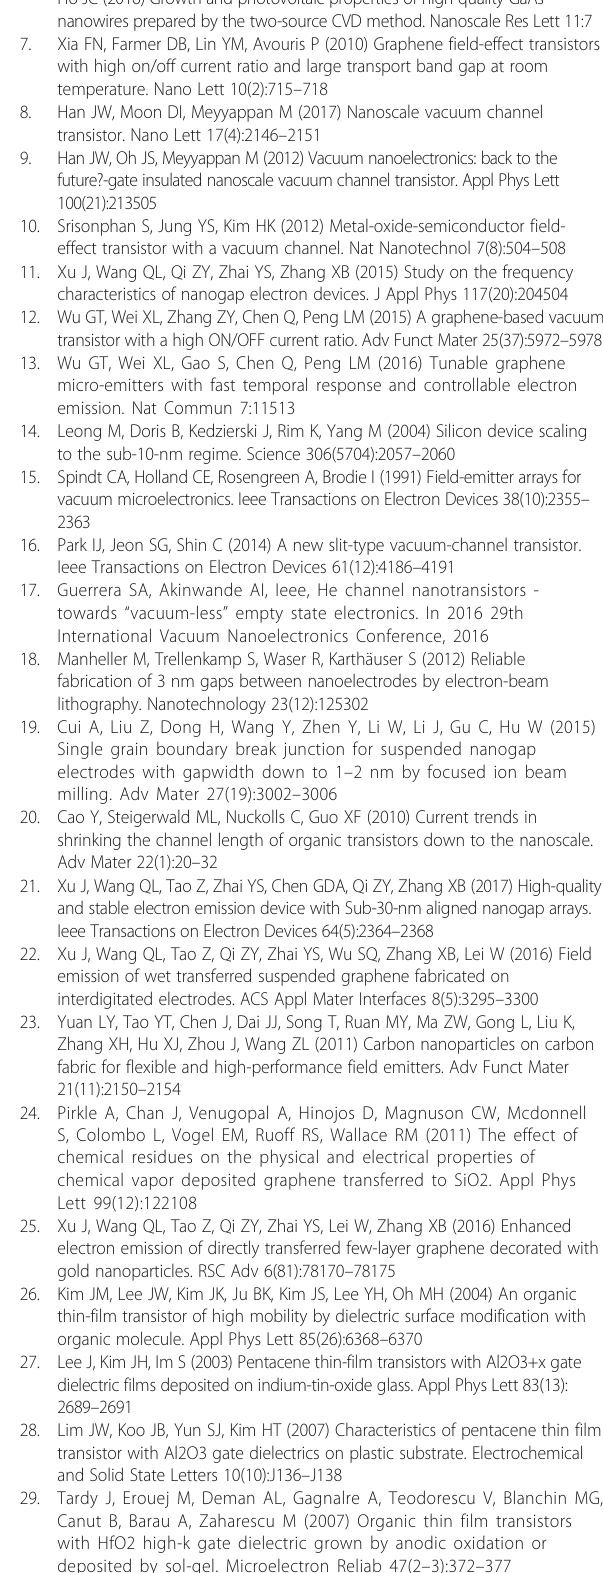
Additional file 1: Figure S1. The schematic diagram and optical picture of the CVD system. Figure S2. The whole structure of the devices. Figure S3. Schematic diagrams of the carriers in solid-state device and the elec- trons in the vacuum nanogap. (DOCX 719